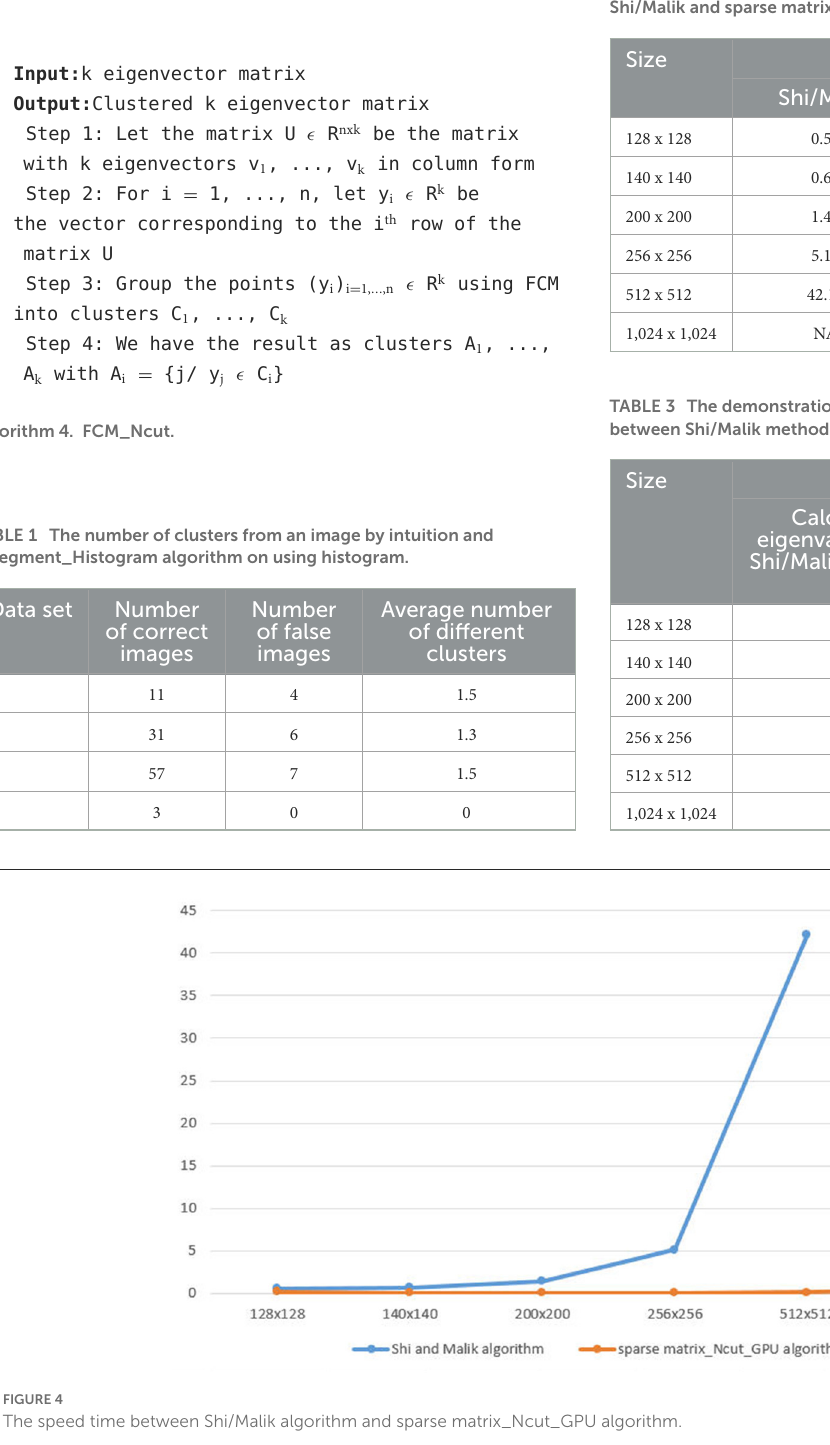
FrontiersinBigData